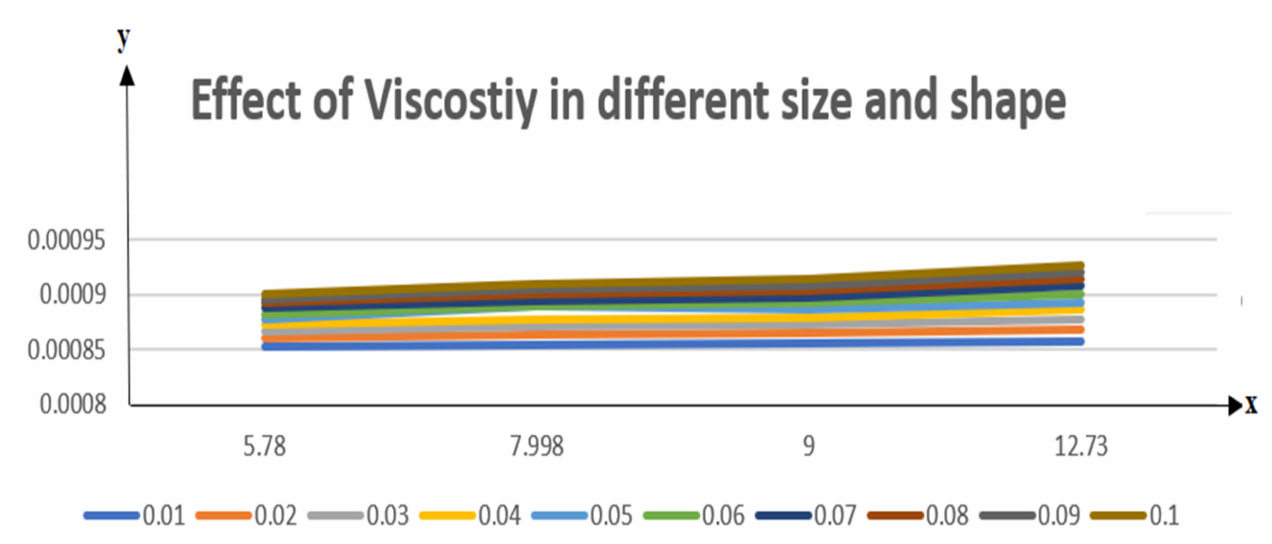
Figure 3. The influence of the scale of hybrid NPs under the viscosity coloring umbrella. Reprinted from [68].